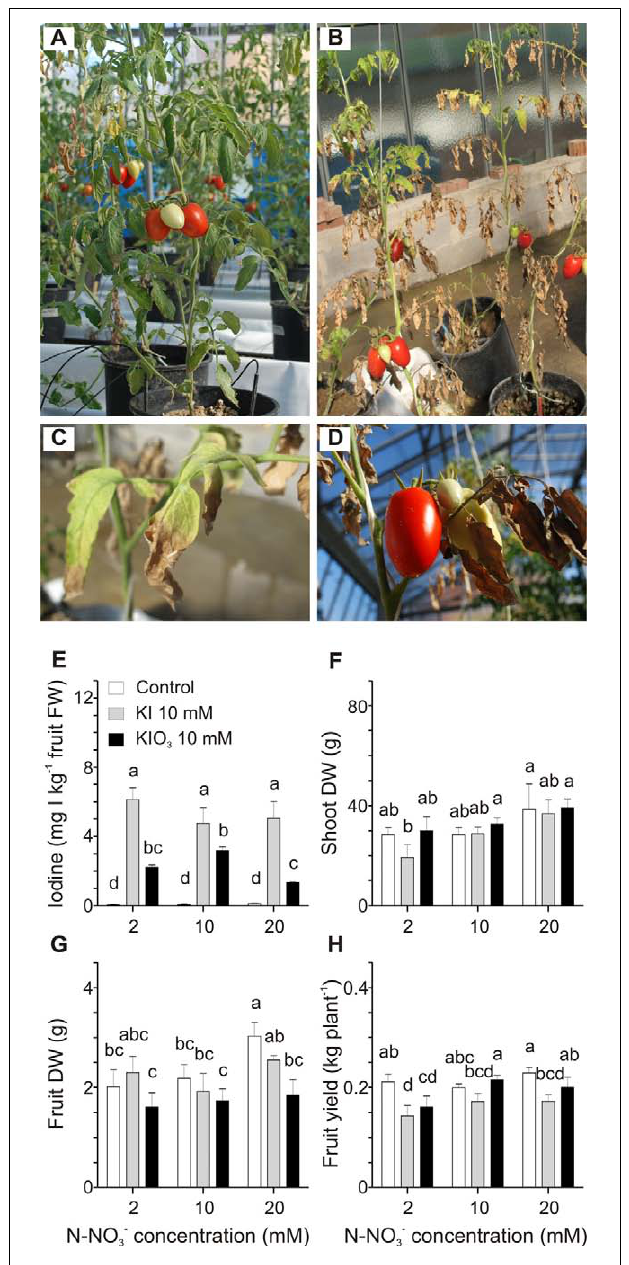
FIGURE 4 | Effect of the nitrate level of the nutritive solution on iodine uptake and accumulation. Plants fertilized with 2 mM nitrate without iodine treatments (A) , or treated with 10 mM KI (B) are shown. Details of leaves from the upper branches (C) and fruits (D) from plants fertilized with 2 mM nitrate and treated with 10 mM KI. Iodine levels in fruits (E) , shoot dry weight (DW) (F) , fruit DW (G) , and fruit yield (H) measured in plants fertilized with 2, 10 or 20 mM nitrate level and with or without 10 mM KI or 10 mM KIO 3 treatments. Data were subjected to one-way and two-way analysis of variance (ANOVA) and the means were separated using the F -test (95.0% confidence level). Significance of two-way analysis of variance (* P -value ≤ 0.05; *** P -value ≤ 0.001; n.s. = not significant): (E) nitrate concentration (a): n.s.; iodine treatment (b): ***; a x b: n.s.. (F) nitrate concentration (a): *; iodine treatment ( b ): n.s.; a x b: n.s.. (G) nitrate concentration (a): n.s.; iodine treatment (b): *; a x b: n.s.. (H) nitrate concentration (a): n.s.; iodine treatment (b): *; a x b: